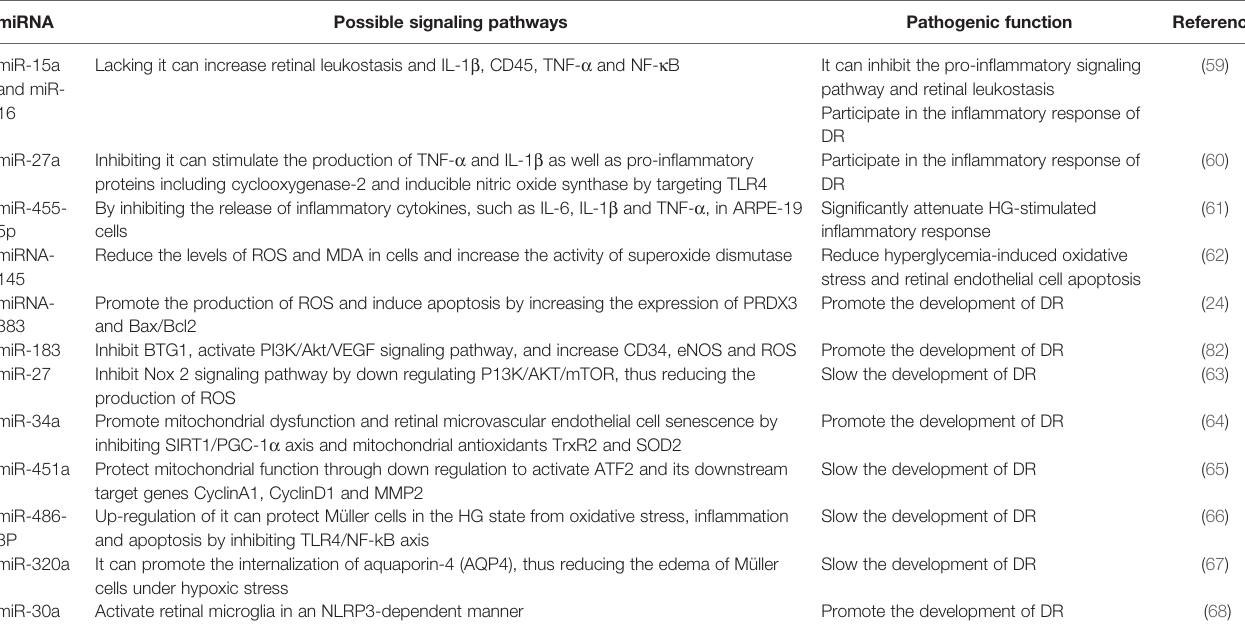
TABLE 2 | Research progress of MiRNAs and their target molecules in the pathogenesis of DR. miRNA Possible signaling pathways Pathogenic function